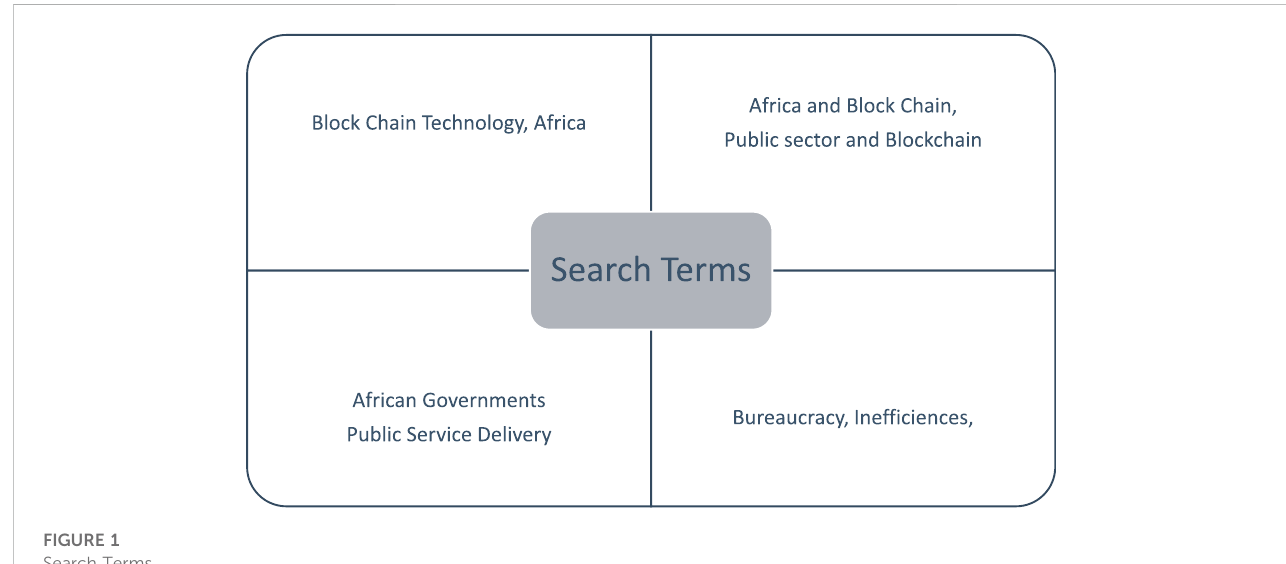
FIGURE 1 Search